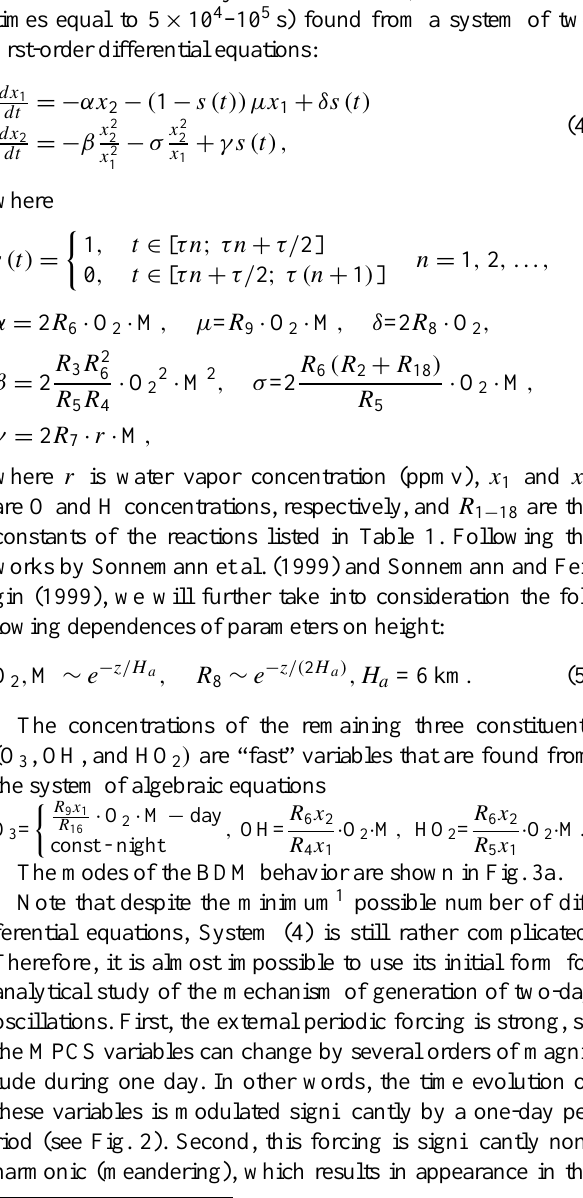
Fig. 3. (a) Bifurcation diagram demonstrating modes of behavior of the initial system of equations for MPCS BDM as a function of height; (b) oscillations of H concentration at 83km (blue curve) and 83.06km (red